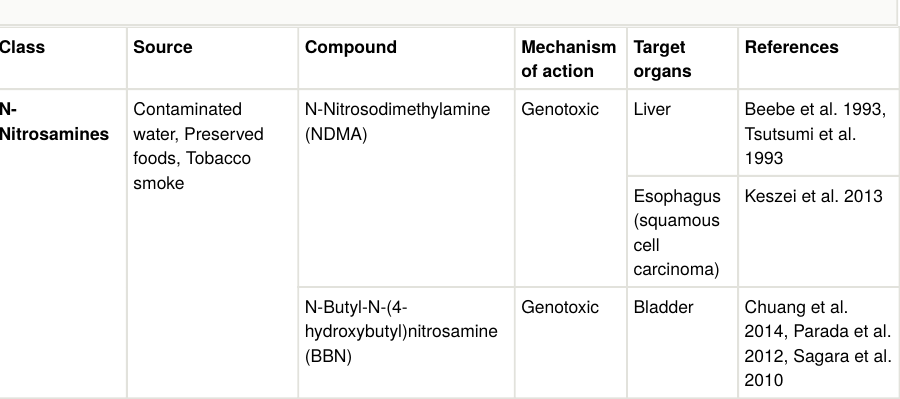
List of the most common environmental molecules (genotoxics and endocrine disruptors) and the di ff erent types of cancers developed following their